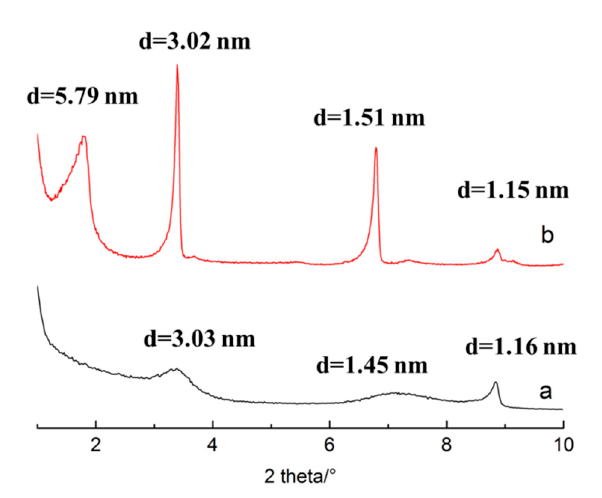
Figure 6. Stability test of the intercalated products in the solution: a . the intercalated sericite was used as raw material and DMSO was used as a solvent, at 80 °C for 24 h; b . the intercalated sericite was used as raw material, CTAB (the amount of CTAB was 15 times the cation exchange capacity (CEC) of S3) and DMSO were used in the solution at 80 °C for 24 h.